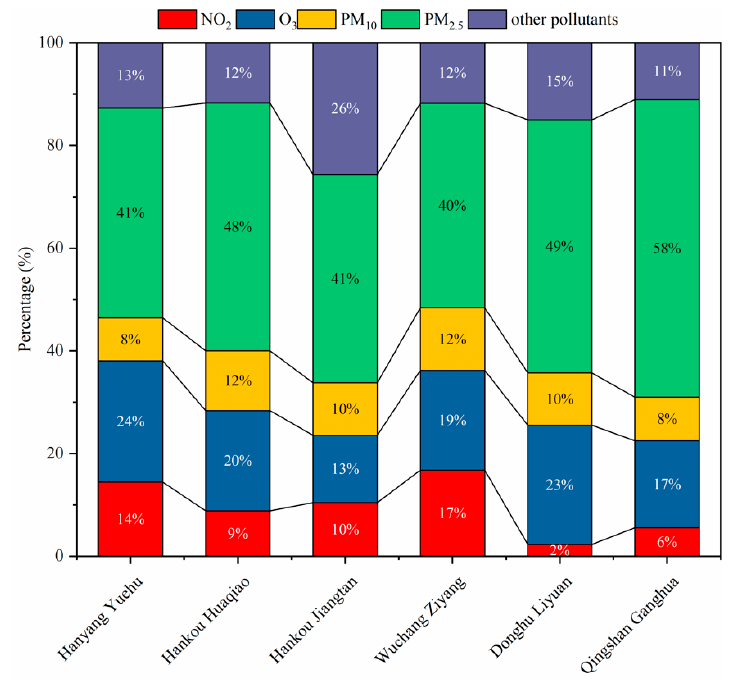
Figure 7. Percentage of major pollutants at various monitoring sites in the period of 2013–2017.